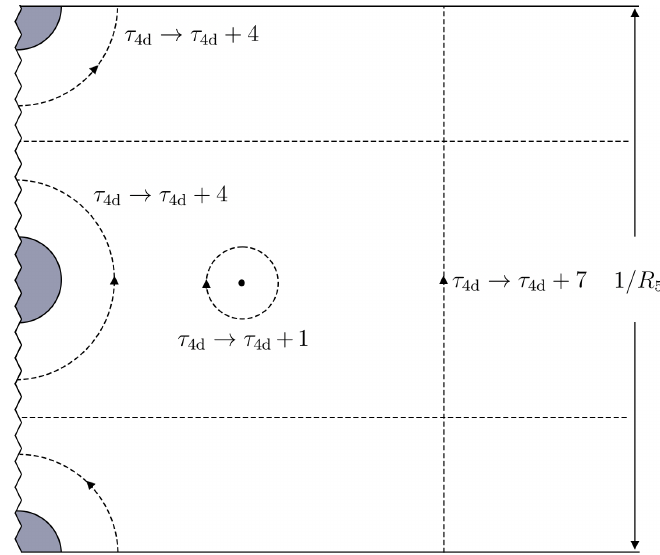
Figure 9 . Schematics of the dP 2 moduli space; again, the top and the bottom boundaries should be identified while the left end should be folded in half. The two holonomy saddles toward the left end are well approximated by a 4d Sp(1) theory with a single flavor and a 4d pure Sp(1) theory,